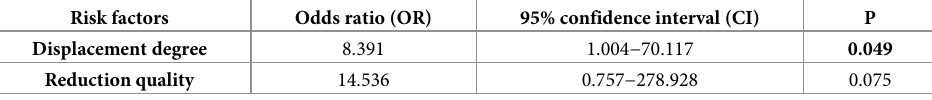
Table 3. Logistic regression analysis and proofreading of the degree of displacement and quality of